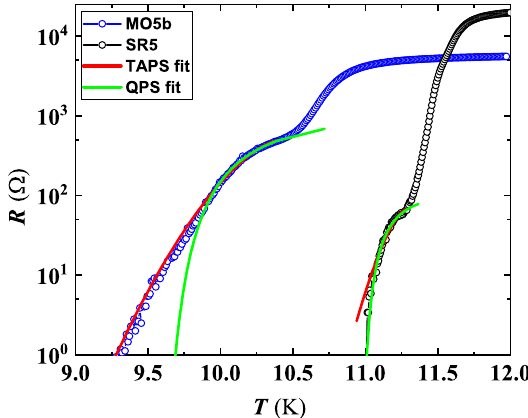
Figure 9. Temperature dependence of resistance for two 5 nm thick NbN films. Both curves showed tailing-like features below about 10.5 and a 11.5 K for MO5b and SR5, respectively. Branches of the ρ ( T ) curves exhibiting the transition at the lower T range were fitted by using LAMH theory, Equation (6) (red lines), and by Equation (9) (green